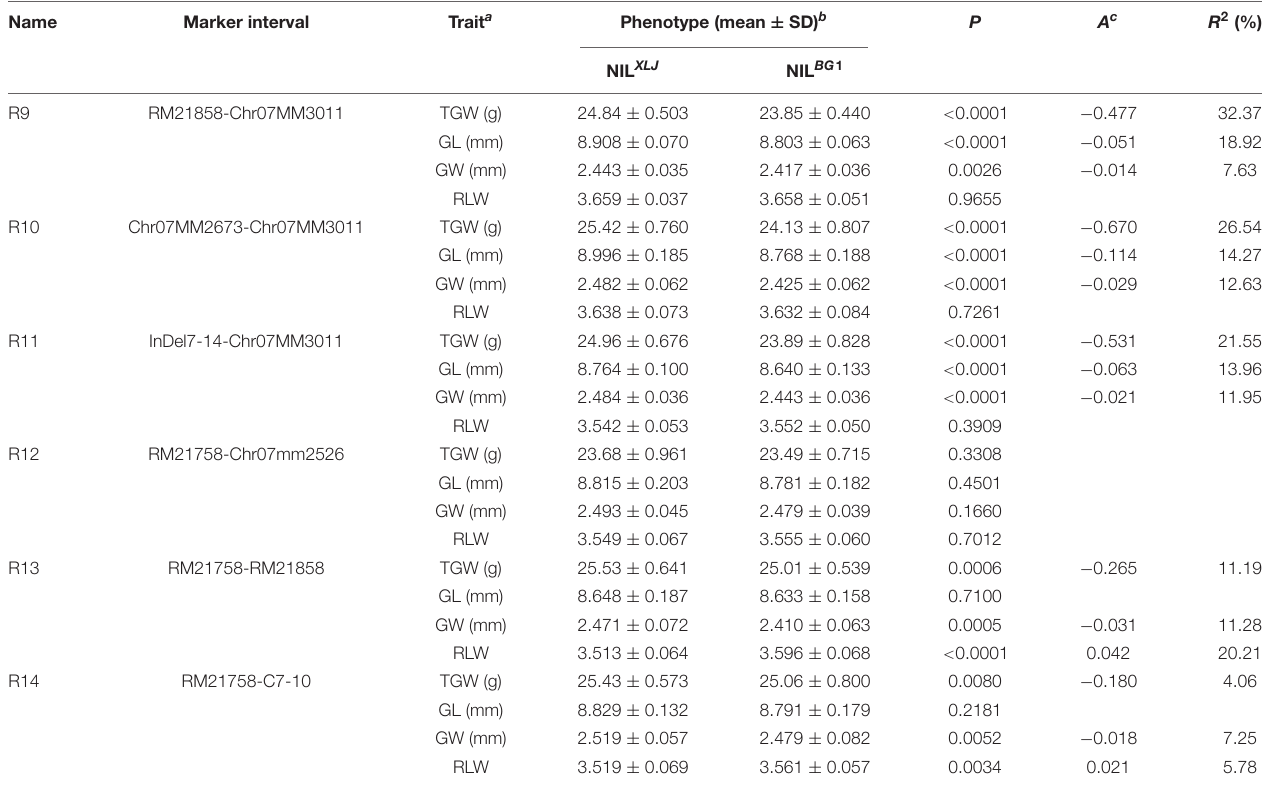
TABLE 2 | Dissection of qGS7.1 into two quantitative trait loci (QTLs) using six residual heterozygous populations in BC 4 F 8